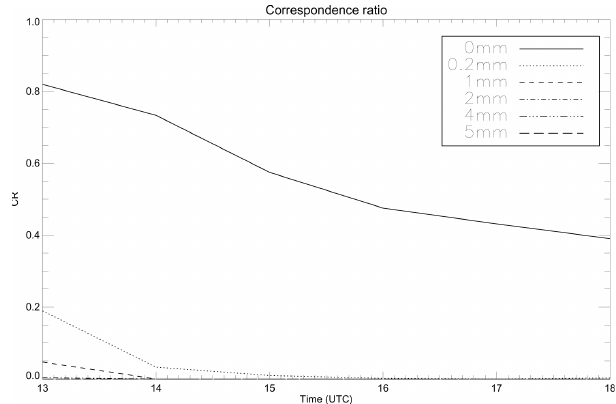
Fig. 11. Correspondence ratio for the control ensemble for hourly rain